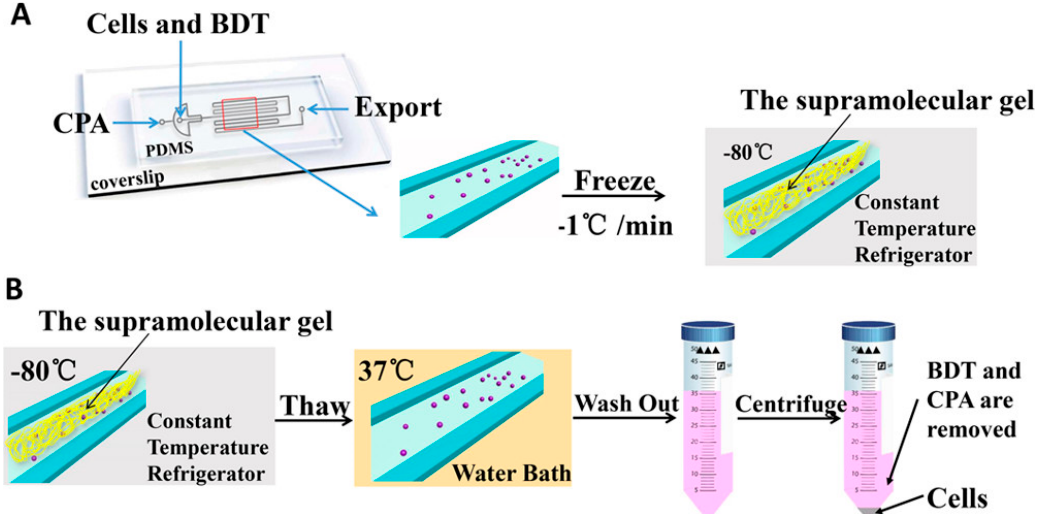
Figure 7. Process of cell freeze–thawing in the microchannel [72]. BDT: Boc- O -dodecyl- L -tyrosine; PDMS: polydimethylsiloxane. ( A ) cell cryopreservation; ( B ) cell thawing.